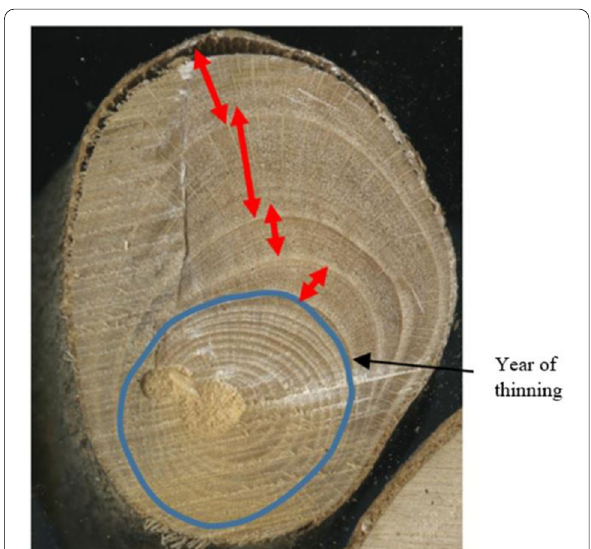
Fig. 1 Photo of a root cross-section showing the orientation of the maximum width for each annual ring. In red, the maximum width roughly follows the direction of the upper